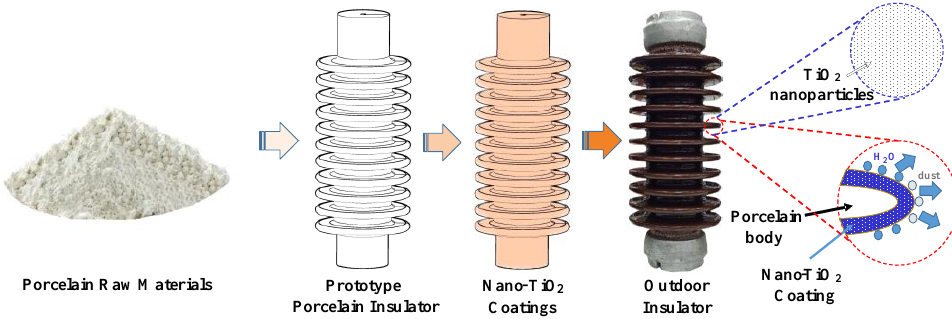
Figure 4. Schematic of the design concepts for nano-TiO 2 coatings of outdoor insulators in this study.